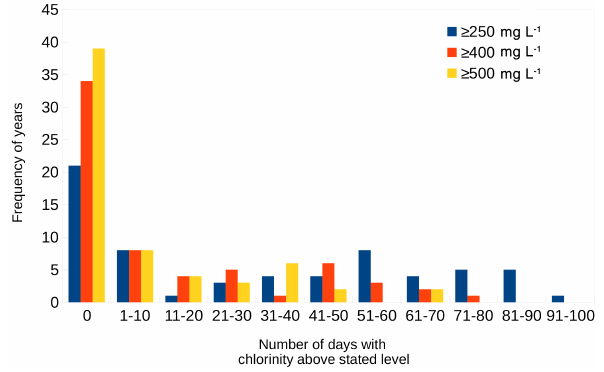
Figure 5. Frequency distribution of years, classified by number of days with high